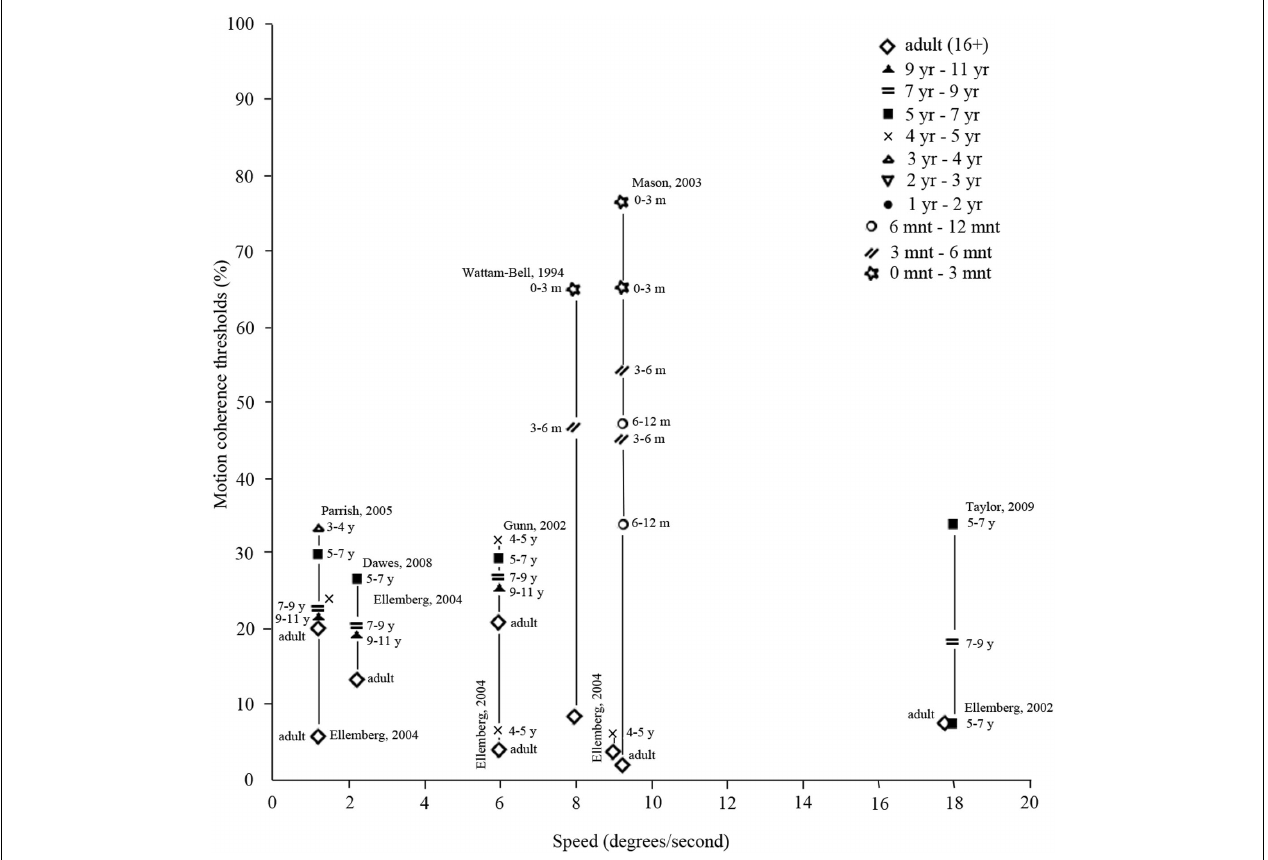
thresholds depend on speed of motion ( x -axis), as well as on age (symbols). (Data points taken fromWattam-Bell, 1994; Banton and Bertenthal, 1996; Ellemberg et al., 2002, 2004; Gunn et al., 2002; Mason et al., 2003; Parrish et al., 2005; Dawes and Bishop,